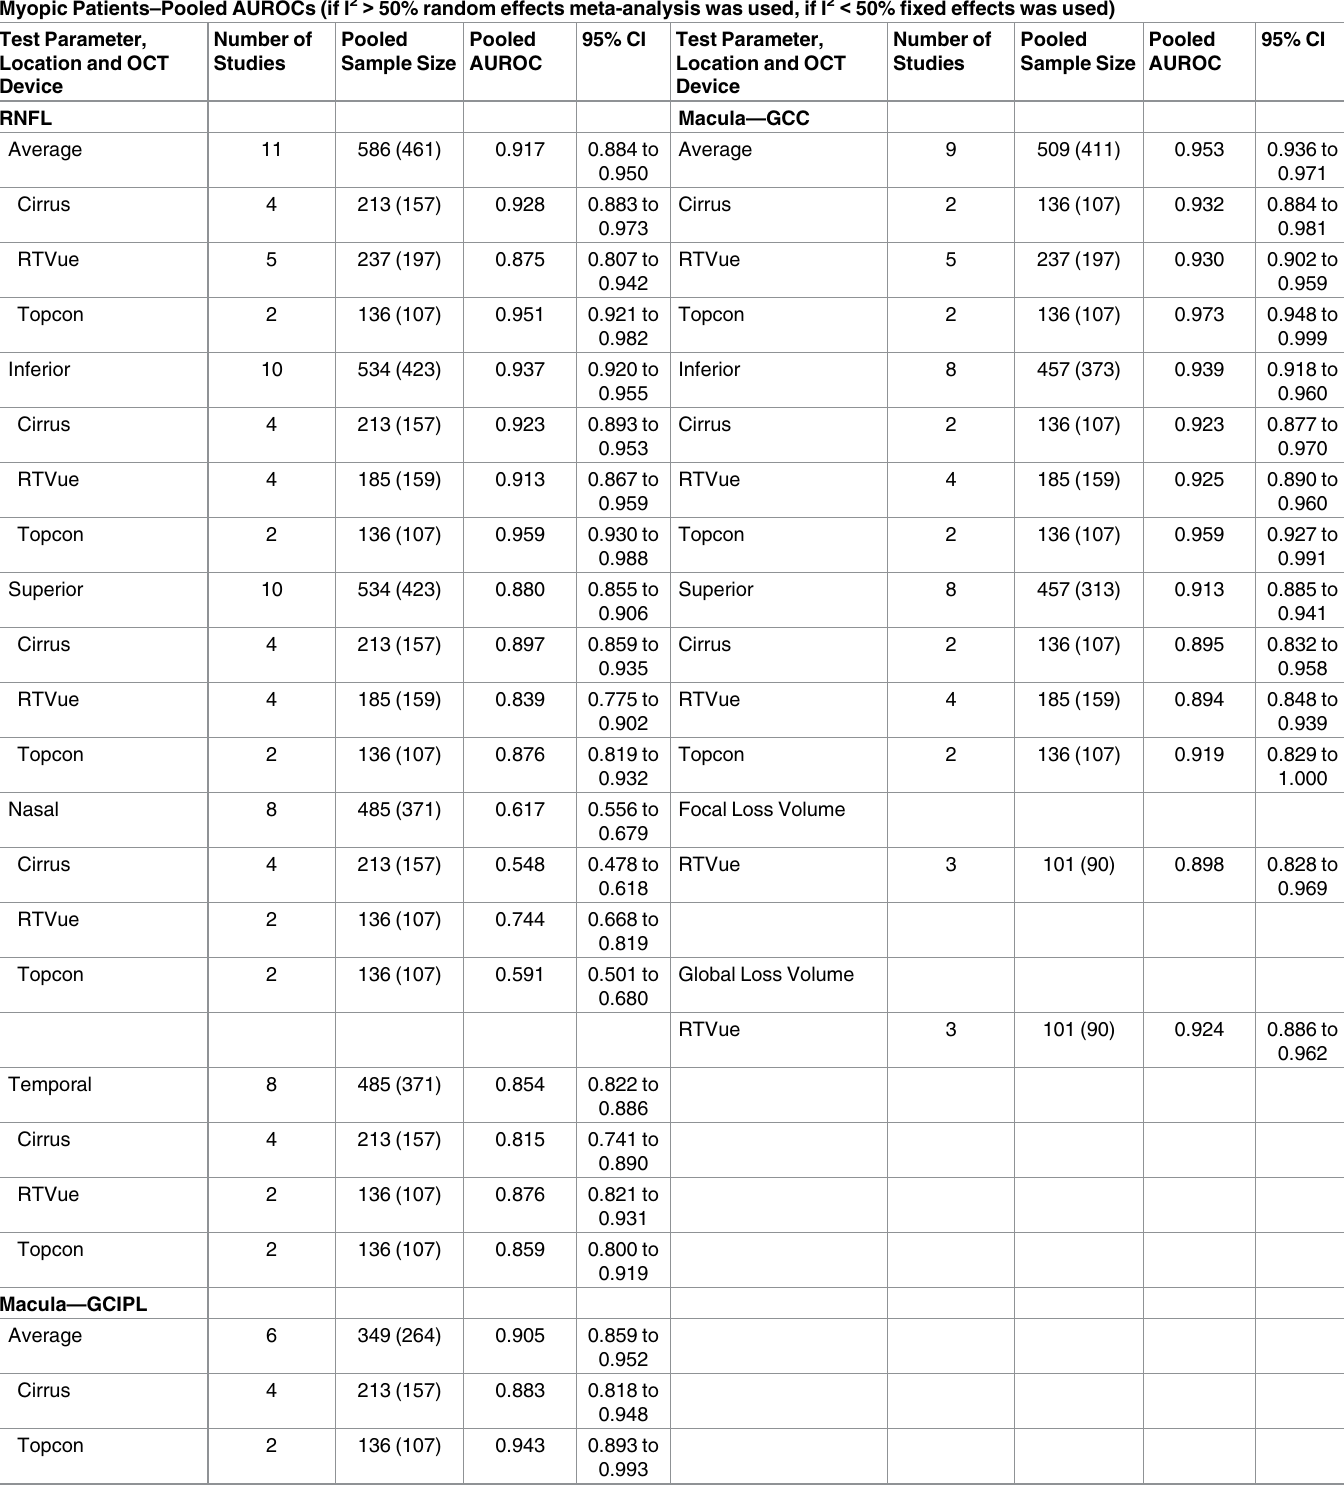
Table 7. Pooled AUROCs of RNFL and macular OCT parameters for myopic